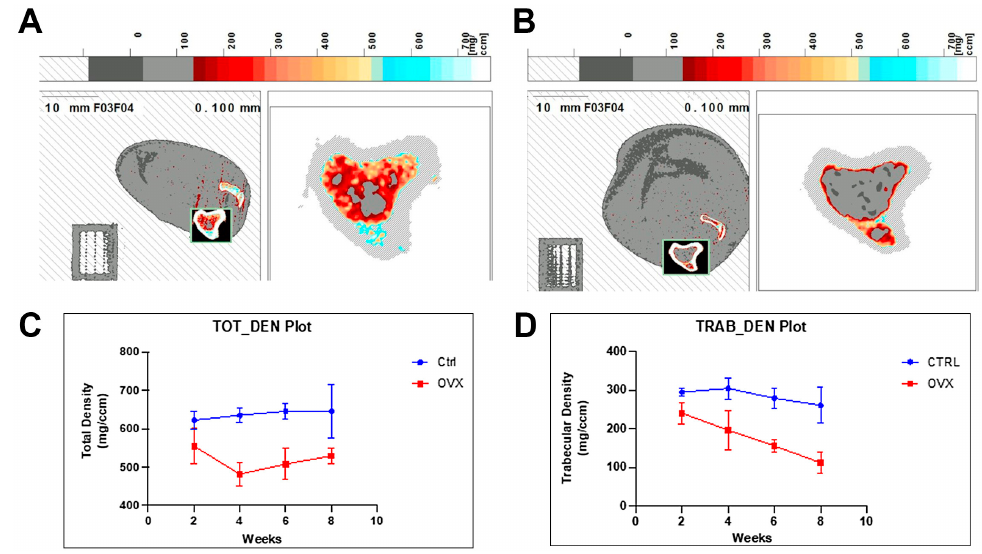
Figure 2. Osteoporotic induction. ( A ) pQCT analysis of the left proximal tibia metaphysis after 8 weeks of non-OVX and ( B ) OVX rats. ( C ) Volumetric cancellous bone mineral density and ( D ) volumetric total bone mineral density in CTRL and OVX rats over 8 weeks (n = 3 per group). Histological examination of the metaphysis in femurs of the CTRL (n = 3) and OVX group (n = 3) 8 weeks post-ovariectomy confirmed the severe osteoporotic phenotype (Figure 3). The monitored blood sugar values at week 0 (129.3 ± 2.5 mg/dL), week 4 (138.7 ± 23.5 mg/dL), and week 8 (129.0 ± 21.1 mg/dL) determined for the OVX animals did not show any significant increase in blood glucose levels over time ( p = 0.6222; see Table 3).